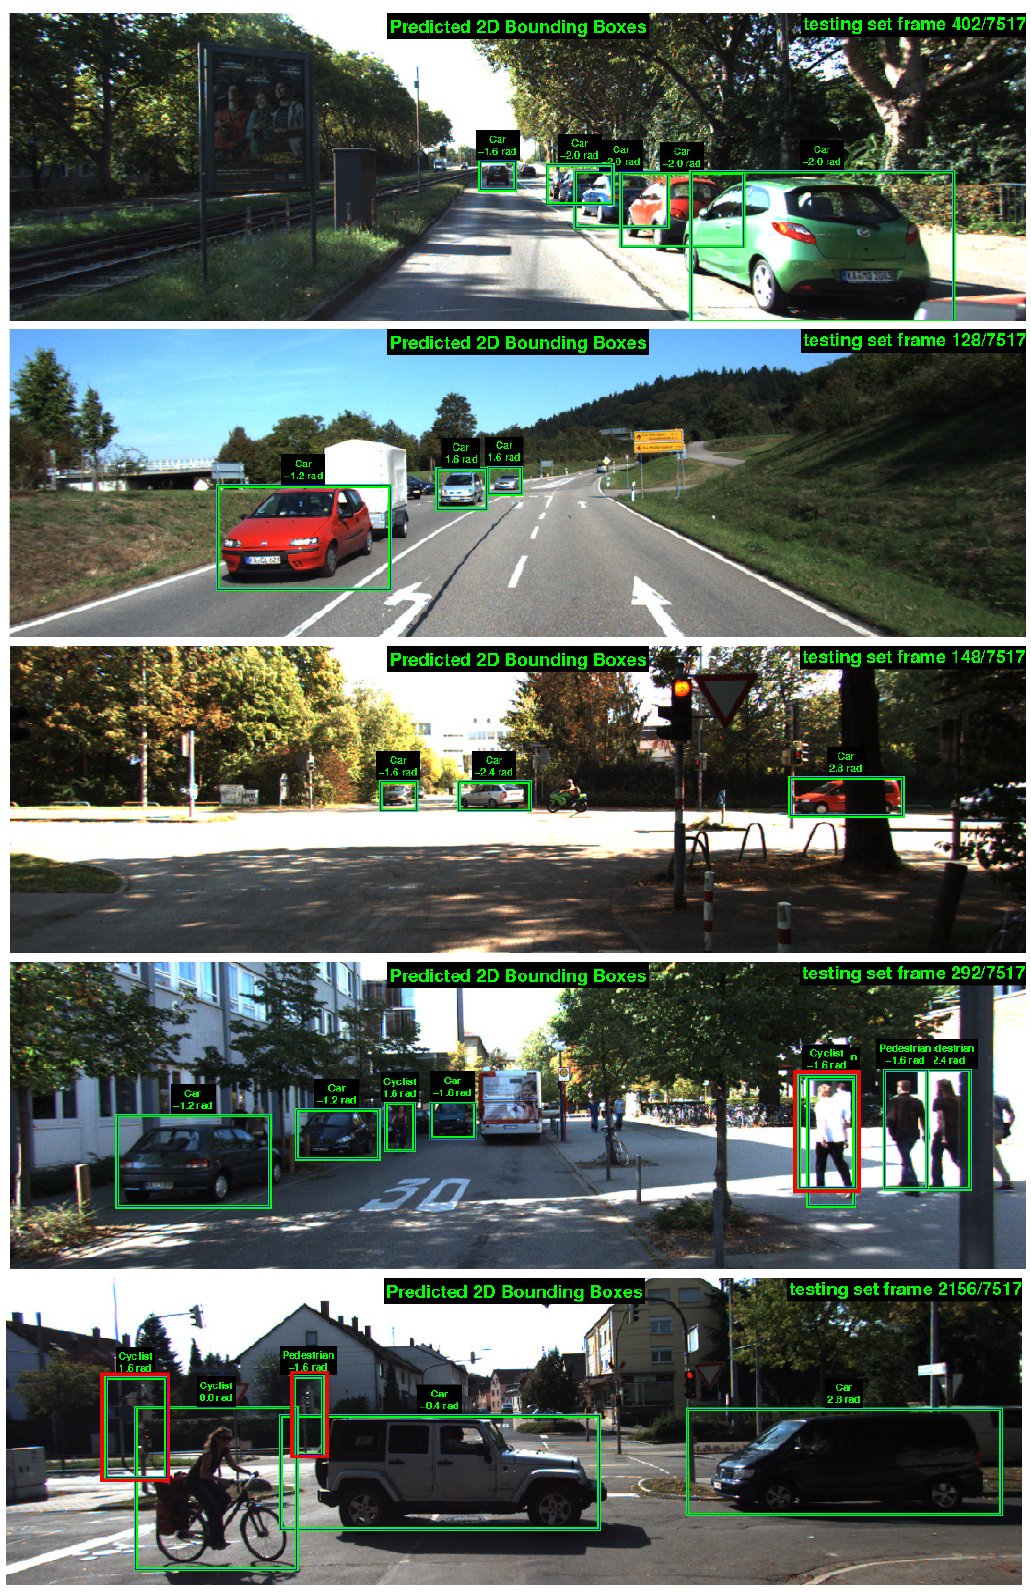
Figure 12. Examples of predicted labels in KITTI testing frames with true positives (green), false positives (red) and false negatives (not